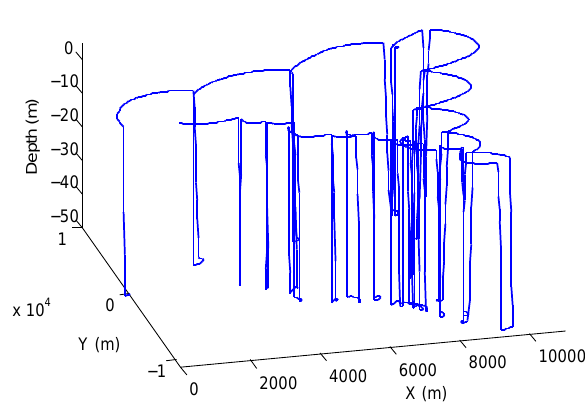
Figure 9: Trajectory of the profiler (weight model